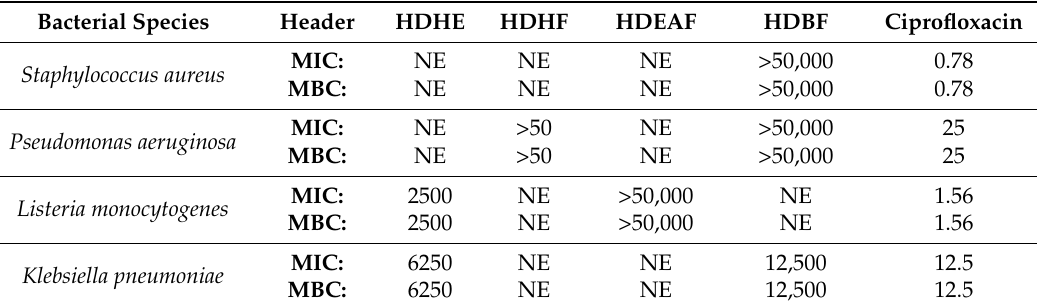
Table 2. Minimum Inhibitory (MIC) and Minimum Bactericidal Concentrations (MBC) of hydroalcoholic extract from leaves of Himatanthus. drasticus and its fractions. Bacterial